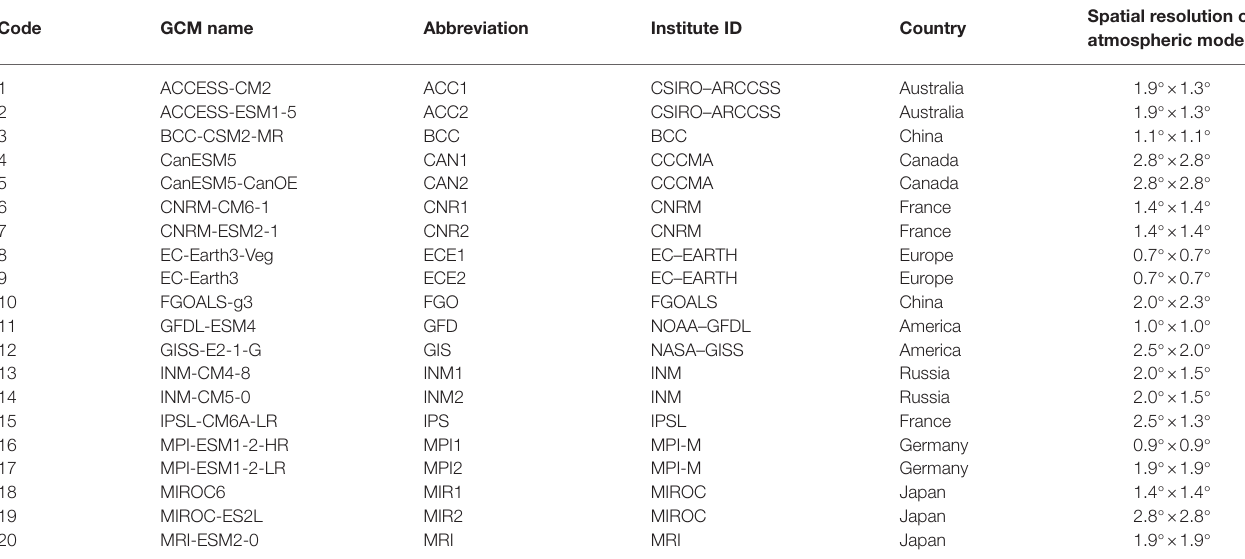
TABLE 2 | List of the 20 Global Climate Models (GCMs) for future climate projections used in this study.